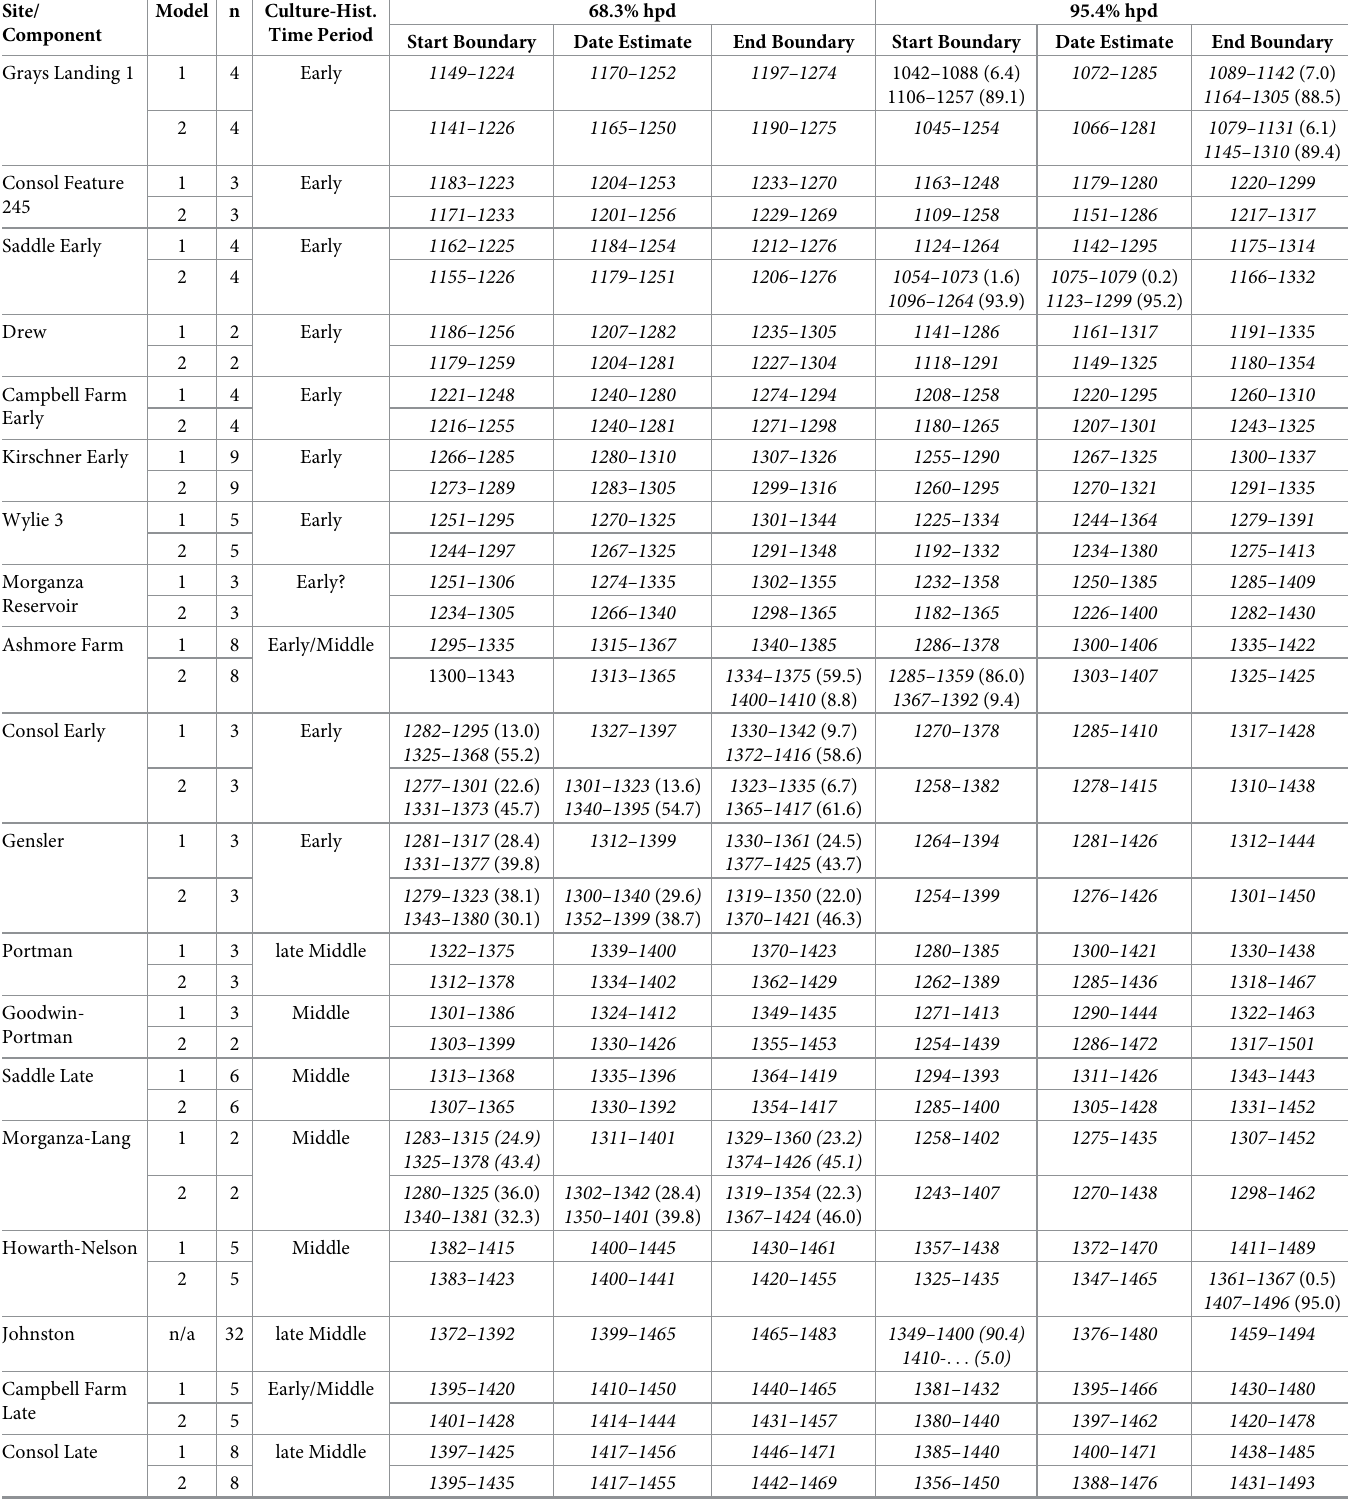
Table 2. Start boundaries, Date estimates, and End boundaries for sites/site components west of Chestnut Ridge. Site/